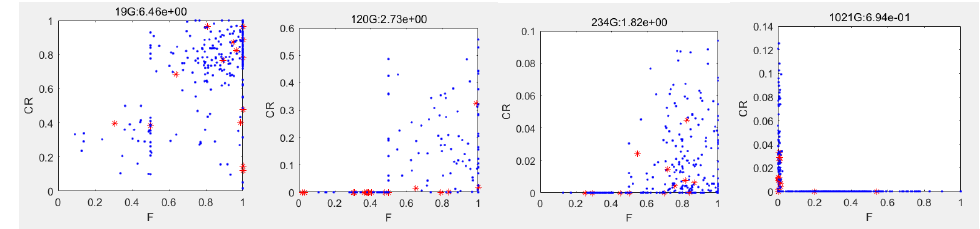
Figure 5. The process of p arameter distribution (F*CR) variation for f12 (50D).